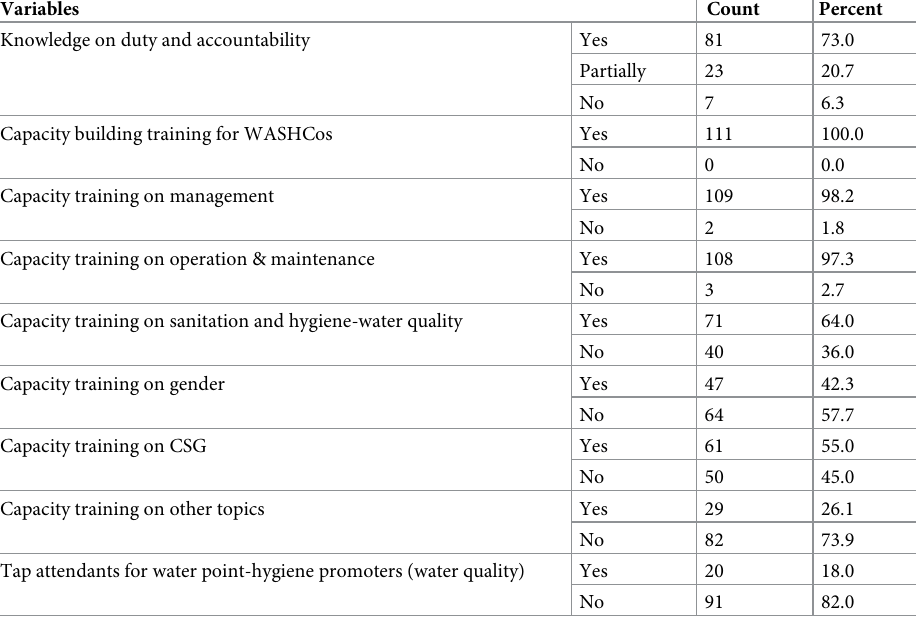
Table 7. Results of institutional related factors in relation to water quality in Afar and Amhara regions of Ethiopia. Variables